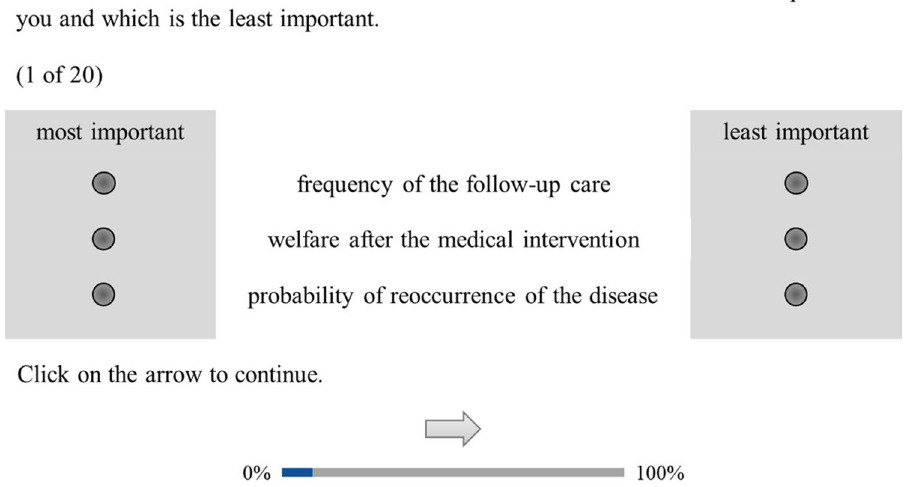
Figure 1. Screenshot of the MaxDiff (maximum-difference scale) choice task.